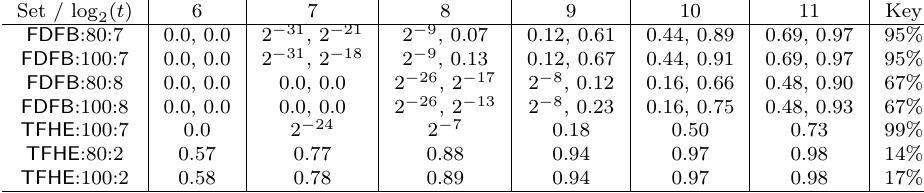
Table 4: Correctness. The table contains upper bounds on the probability to have an error in the outcome of the bootstrapping algorithms. For our full domain bootstrapping, we give two values. The first is the upper bound on the error probability for ciphertexts after bootstrapping. The second value is the upper bound for a ciphertext after bootstrapping and computing an affine function of size 784. That is, a function of the form w + P 784 x i · w i ∈ 0 i =1 Z where x are the input plaintexts, and the w ’s are the weights. We emphasize that the t i i probabilities are upper-bounds, and the empirical correctness errors are much